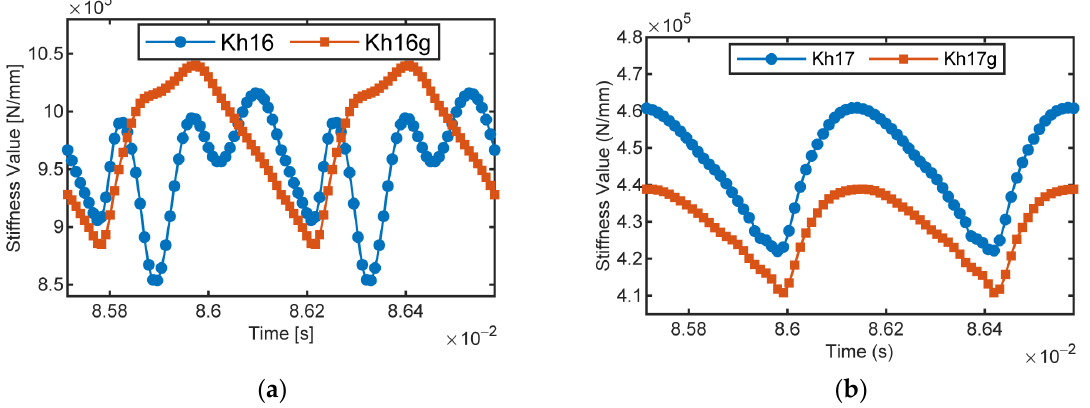
Figure 6. Di ff erence in meshing sti ff ness between fi xed and varying load: ( a ) lower face gear; ( b ) Figure 6. Difference in meshing stiffness between fixed and varying load: ( a ) lower face gear; upper face gear. ( b ) upper face